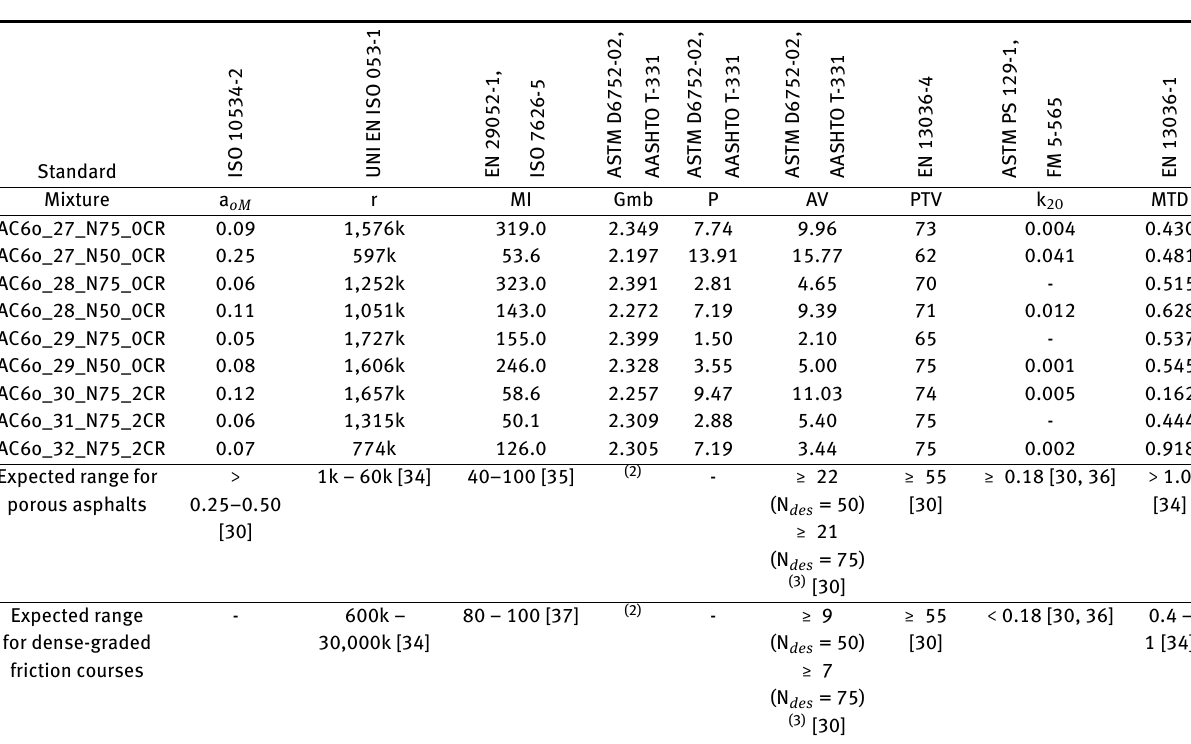
Table 6: Results of preliminary